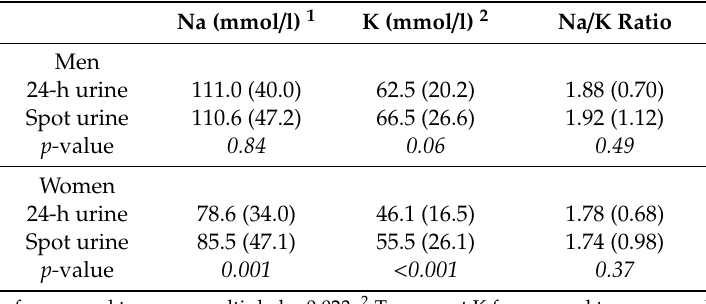
Table 4. Mean sodium (Na), potassium (K), and sodium to potassium ratio (Na / K ratio) in 24-h urine samples and spot urine samples in 232 men and 243 women aged 40–69 years participating in the seventh wave of in the Tromsø study 2015–2016.